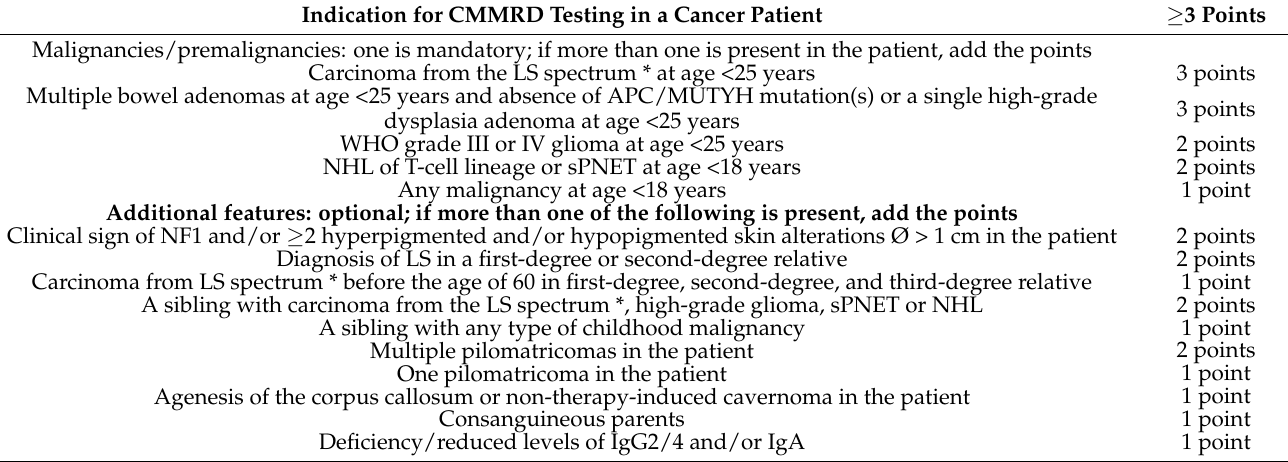
Table 1. Scoring system to determine germline testing in eligibility for CMMRD. Indication for CMMRD Testing in a Cancer